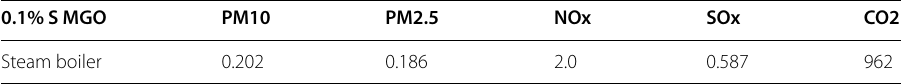
Table 4 Emission factors for auxiliary boilers (g/kWh). Source : Starcrest 2021a;